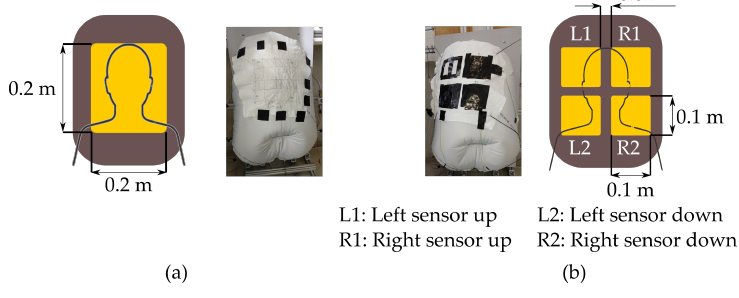
Figure 1. Sensors’ configuration: ( a ) single sensor; ( b ) matrix